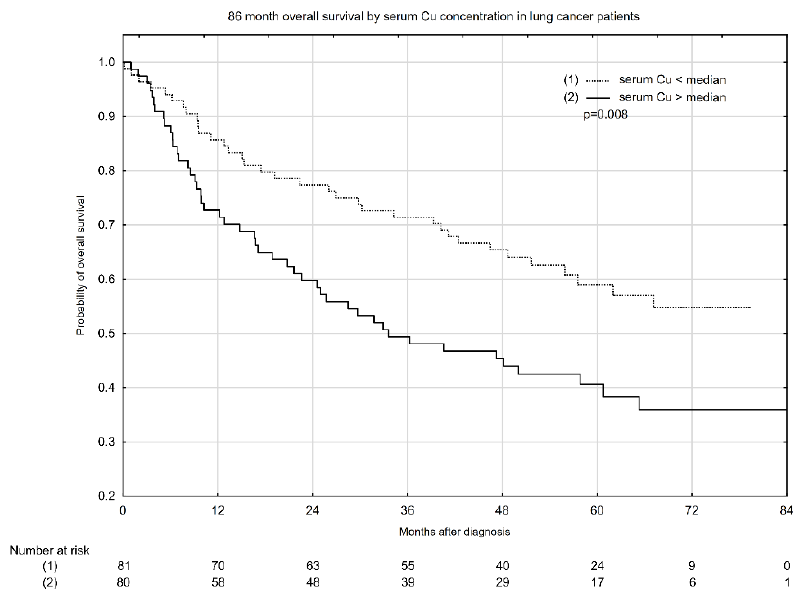
Figure 1. Eighty-six-month overall survival by serum Cu concentration in lung cancer patients.